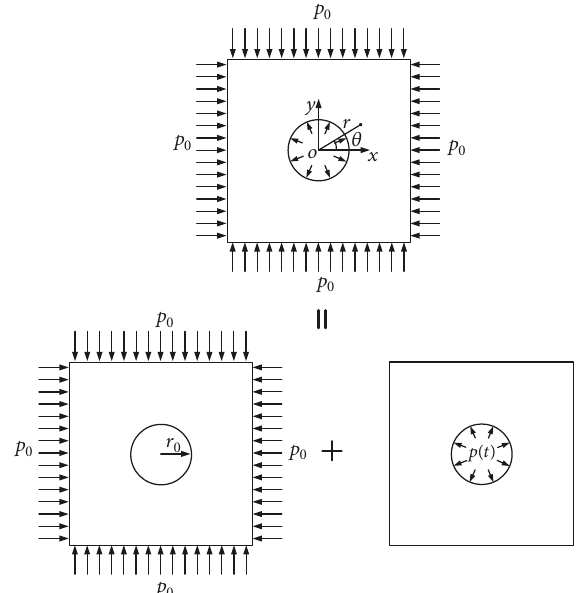
Figure 1: Decomposition of elastic stress field under coupled high axial geostress and blasting